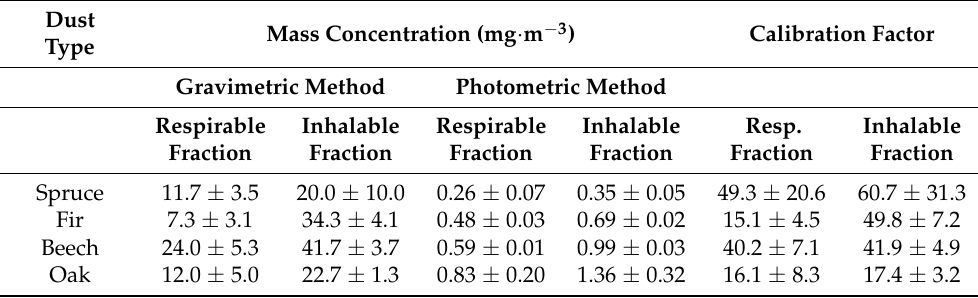
Table 1. Summary of calibration factors for different wood dust types using the gravimetric method compared to photometric monitoring data (arithmetic mean ± standard deviation, n = 3).